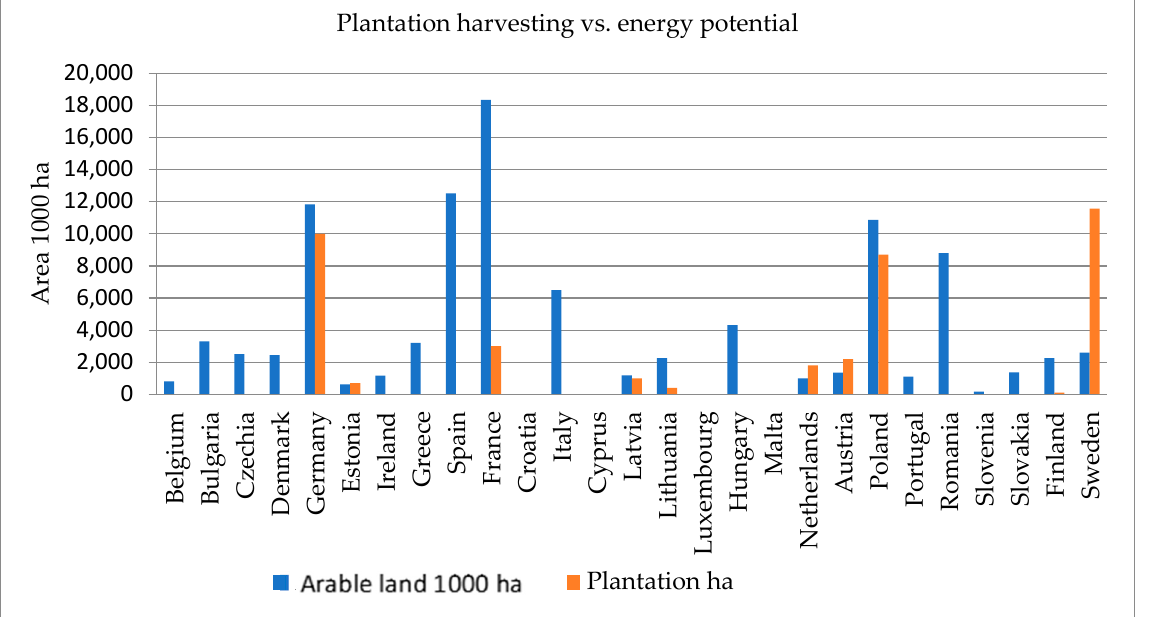
Figure 5. The development of the potential of various dedicated energy crops on arable land or grassland between 2020 and 2022 [150-152].